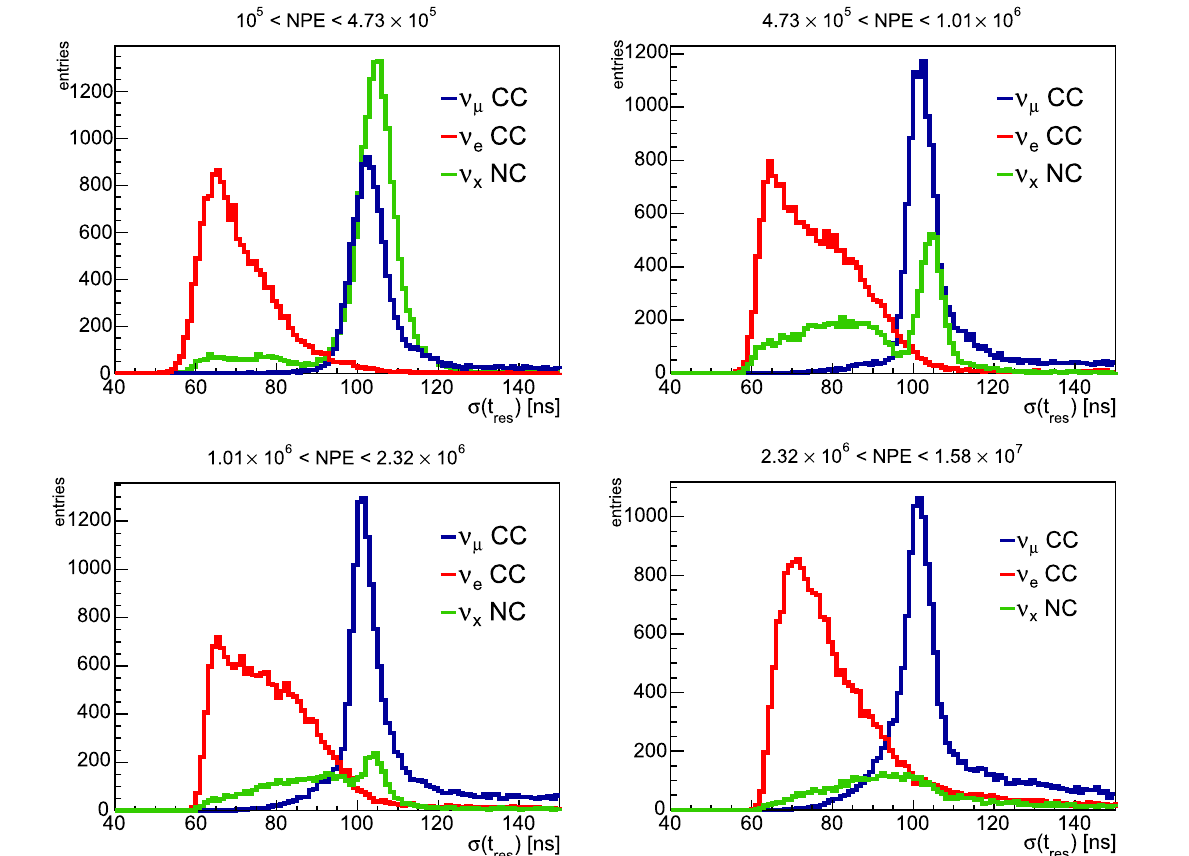
Fig. 4 Distribution of σ( t res ) for ν μ CC (blue), ν e CC (red) and NC events (green), for different ranges of